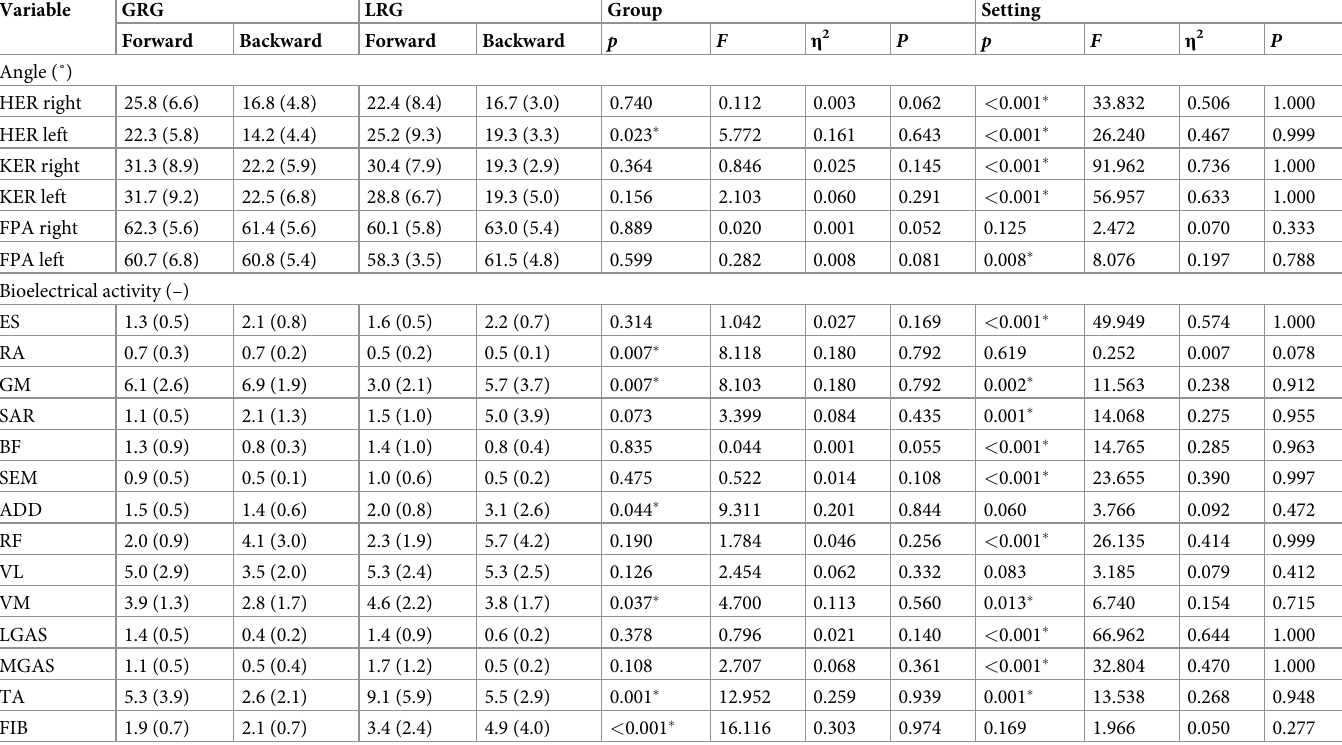
Table 5. Mean (SD) of the angles and bioelectrical activity in the fifth classical position (CP5), and p value, F statistic, effect size estimates and observed power of the repeated-measures ANOVA for group and setting factors. Variable GRG LRG Group Setting